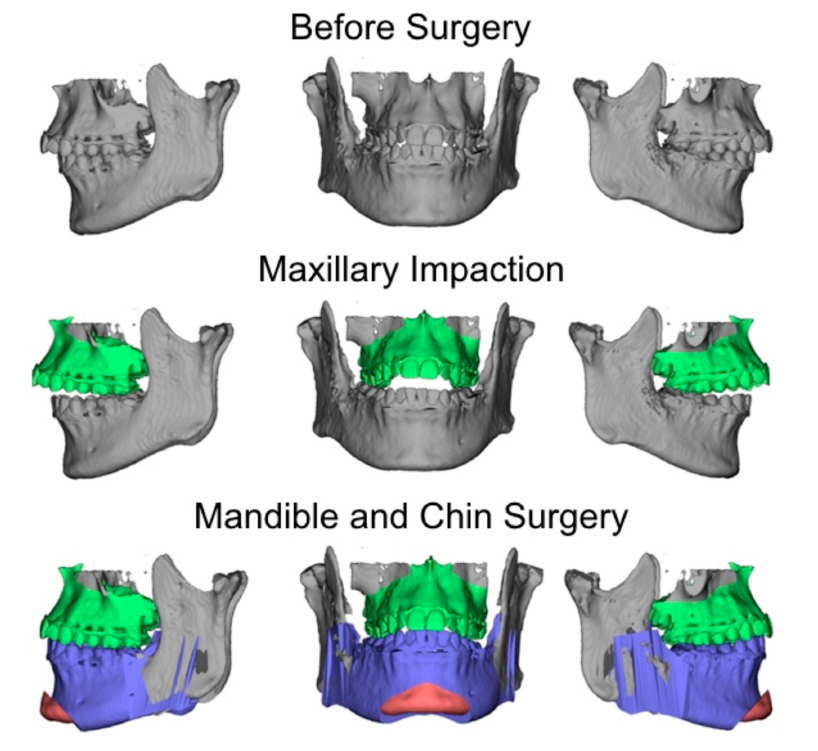
Figure 3. Three-dimensional virtual surgical plan with maxillary impaction, mandibular advance- ment and chin